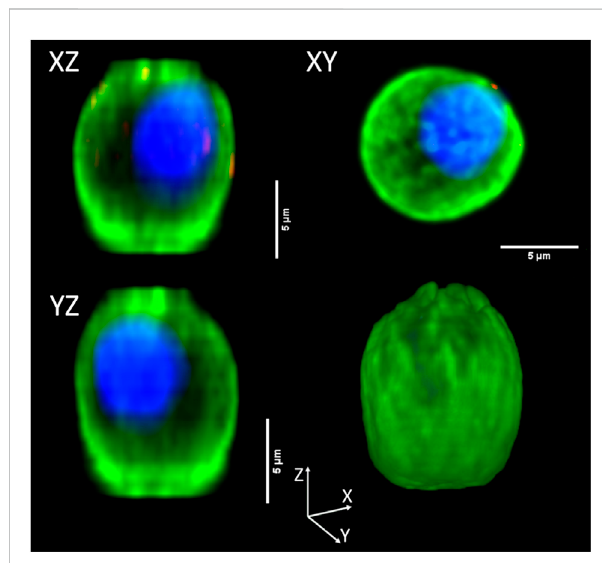
FIGURE 6 Orthogonal view of a three-dimensional reconstructed NRBC. The top and bottom left corner panels, namely, “ XZ ” and “ YZ, ” are the projections along Y and X orthogonal views, respectively ( “ 2DProjXY ” method), the top right corner ( “ XY ” ) is the projection along the Z axis ( “ 2DProjZ ” method). The bottom right corner panel shows the 3D reconstruction ( “ 3DSuite ” method).